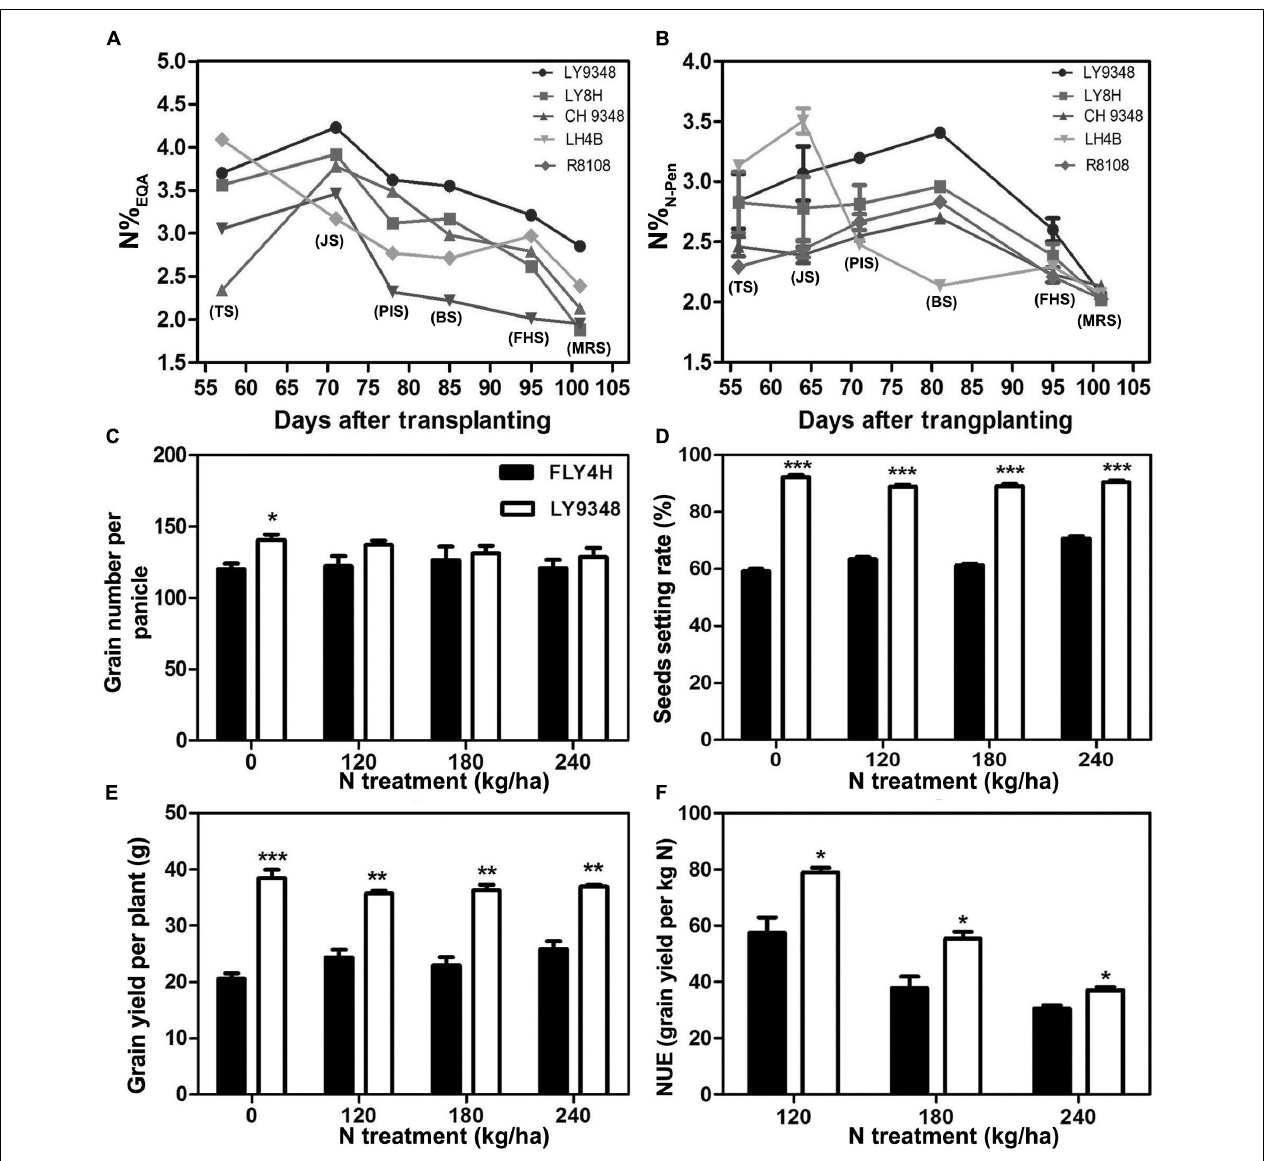
FIGURE 2 | The nitrogen use efficiency analysis of the rice variety LY9348. The nitrogen content was measured by (A) EQA (N% EQA ) and (B) N-pen meter (N% N - Pen ) of different rice varieties. The difference between FLY4H and LY9348 in (C) grain number per panicle, (D) seed setting rate, (E) grain yield per plant, and (F) nitrogen use efficiency (NUE) for different nitrogen treatments (N treatment) ( n = 30). Asterisks denote statistically significant differences between FLY4H and LY9348 (* P < 0.05; ** P < 0.01; *** P < 0.001) analyzed by Student’s t -test. Rice varieties: LY9348 (circle); LY8H (square); CH9348 (upright triangle); LH4B (inverted triangle); and R8108 (diamond). EQA: elementary quantitative analysis. TS, tillering stage; JS, jointing stage; PIS, panicle initiation stage; BS, booting stage; FHS, full heading stage; MRS, milk ripen